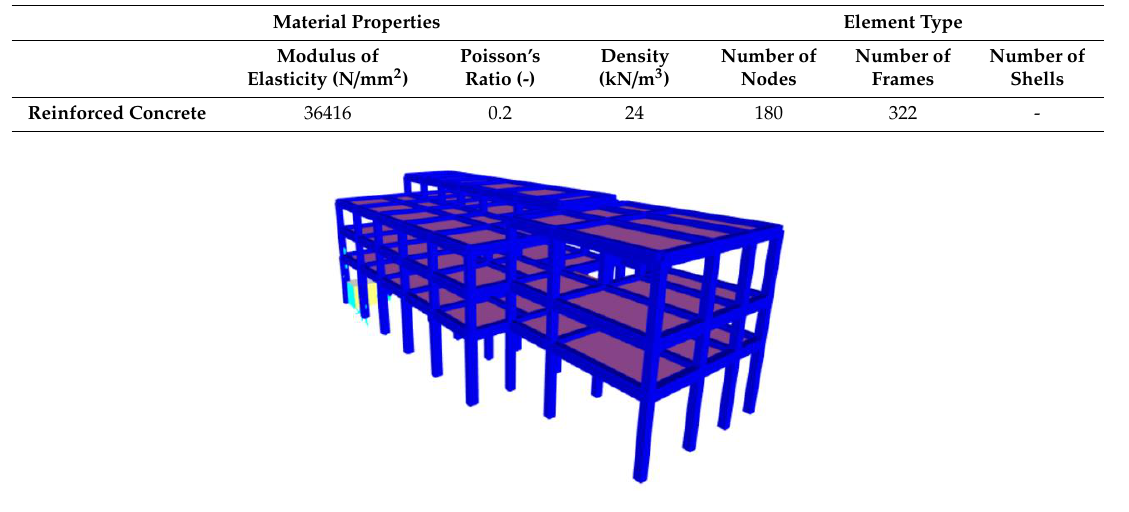
Table 5. Material properties and elements type adopted in the FE models—Structure B.